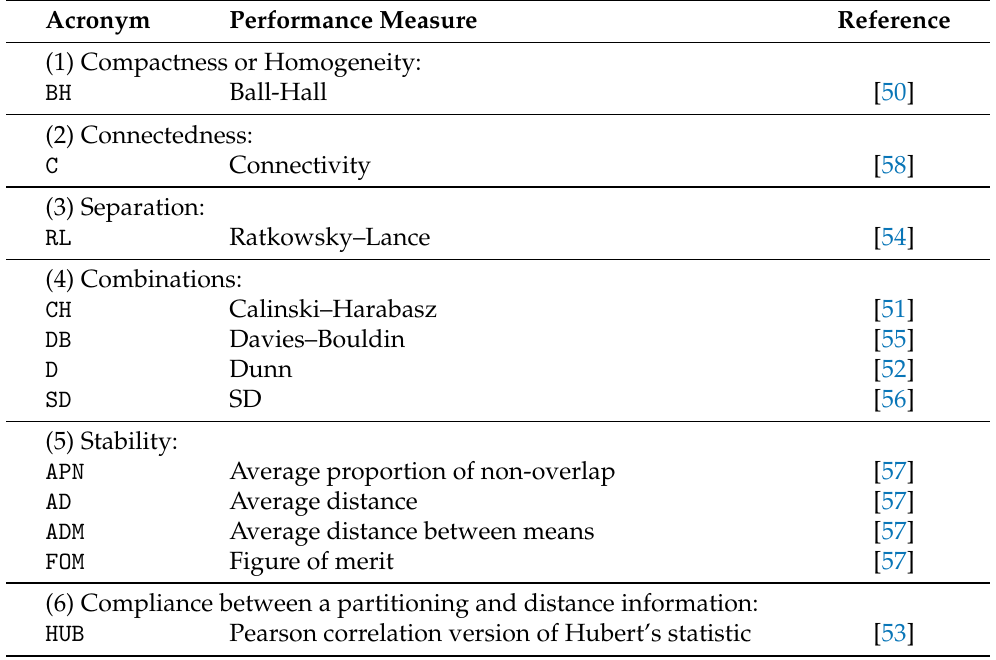
Table 2. Performance measures classified by